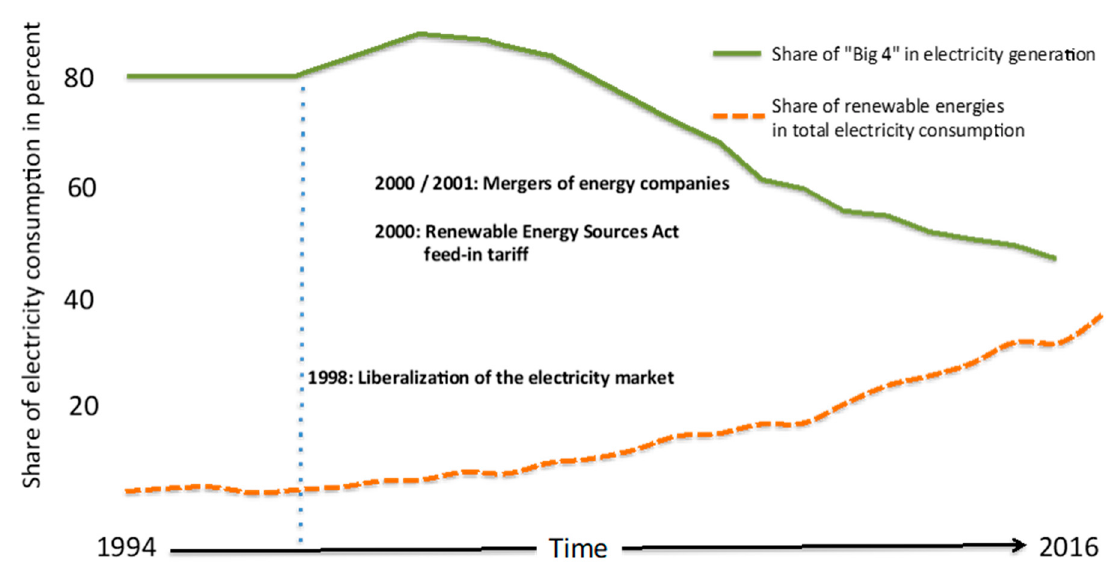
Figure 2. The increasing share of electricity generation from renewable energy and the declining market share of the “Big 4” since the liberalization of the market. Source: Agency for Renewable Energies (German: Agentur für Erneuerbare Energien) [28].